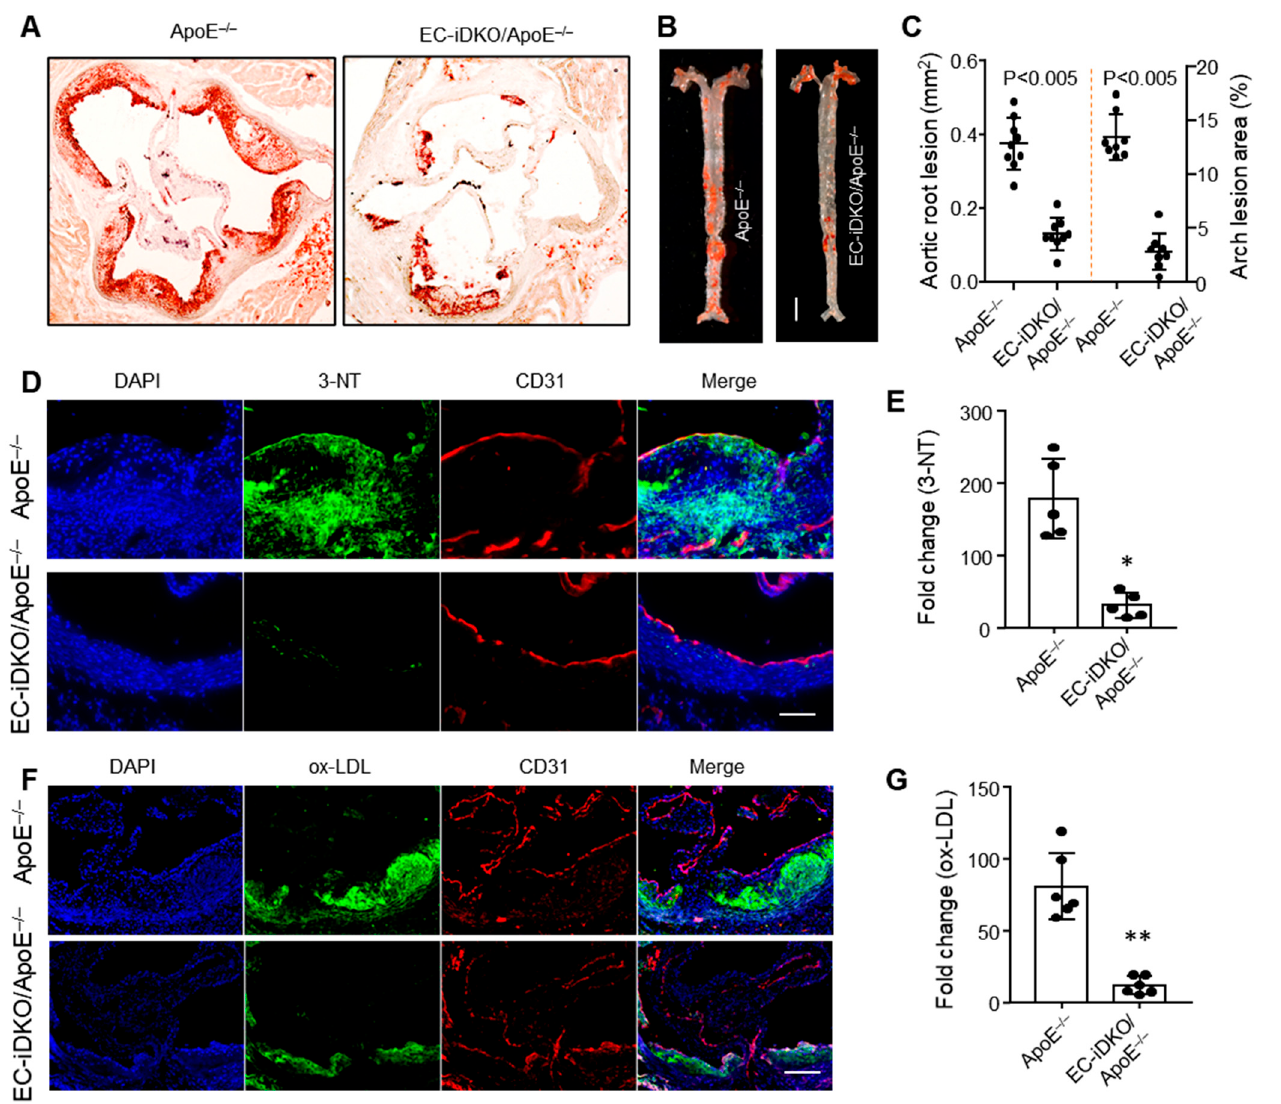
Figure 5. Loss of epsins from the endothelium mitigates atherosclerosis and oxidative stress. ( A – C ) Oil Red O staining for aortic roots, aortic arches, and data quantification, respectively (n = 9 in each group; p < 0.001). Scale bar = 500 µm ( A ) or 5 mm ( B ). ( D , E ) Immunofluorescence staining of 3-NT for reactive nitrogen species (RNS) and quantification (n = 5; * ApoE − / − vs. EC-iDKO/ApoE − / − ; p < 0.005). ( F , G ) Immunofluorescence staining of oxLDL for reactive oxygen species (ROS) and quantification (n = 5; ** ApoE − / − vs. EC-iDKO/ApoE − / − ; p < 0.005).